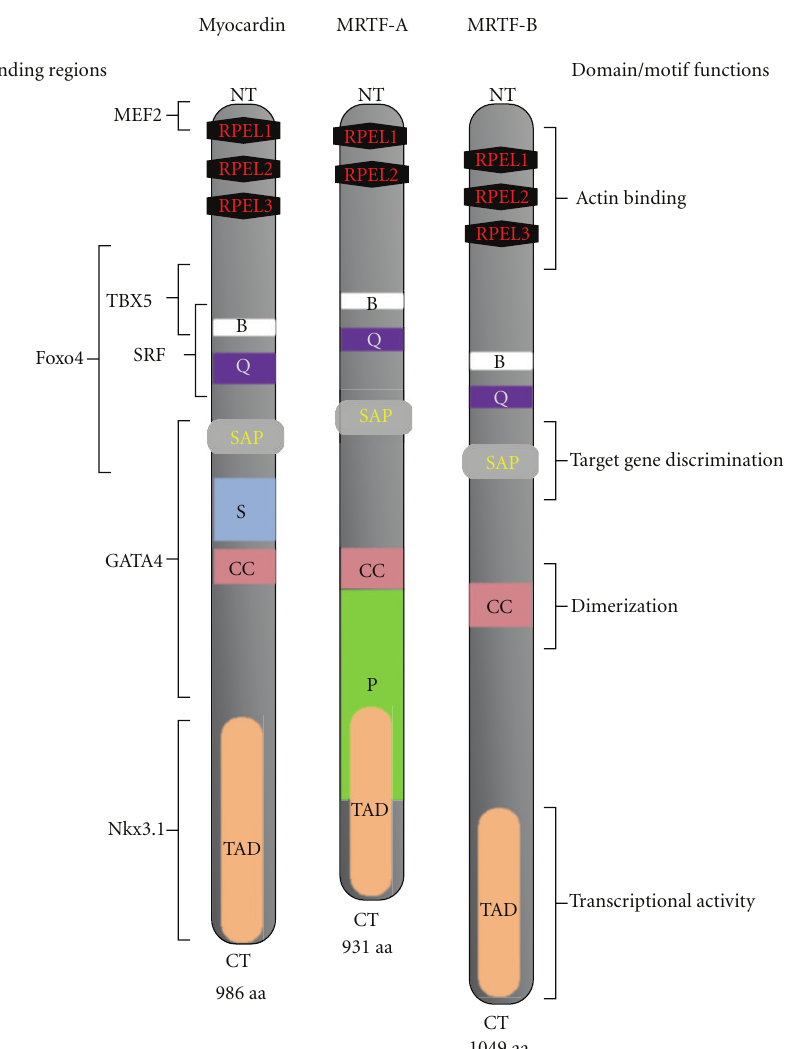
Figure 1: The myocardin family of transcriptional cofactors: protein signatures, domains, and functional sites. The domain/motif structures of the human proteins are shown: RPEL 1-3 (RPEL domain), B: basic domain, Q: glutamine-rich region, SAP: SAP domain; S: serine-rich region; CC: coiled-coil (leucine zipper-like) motif; P: proline-rich region; TAD: transcription activation domain. The regions essential for binding of transcription factors (TF). MEF2: myocyte enhancer factor-2 [32], TBX5: T-box transcription factor 5 [33], FOXO4: forkhead box protein O4 [34], GATA-4: member of GATA family of zinc finger transcription factors [35], NKX-3.1: homeobox NK-3 transcription factor-1 [36]. NT/CT: amino/carboxyl